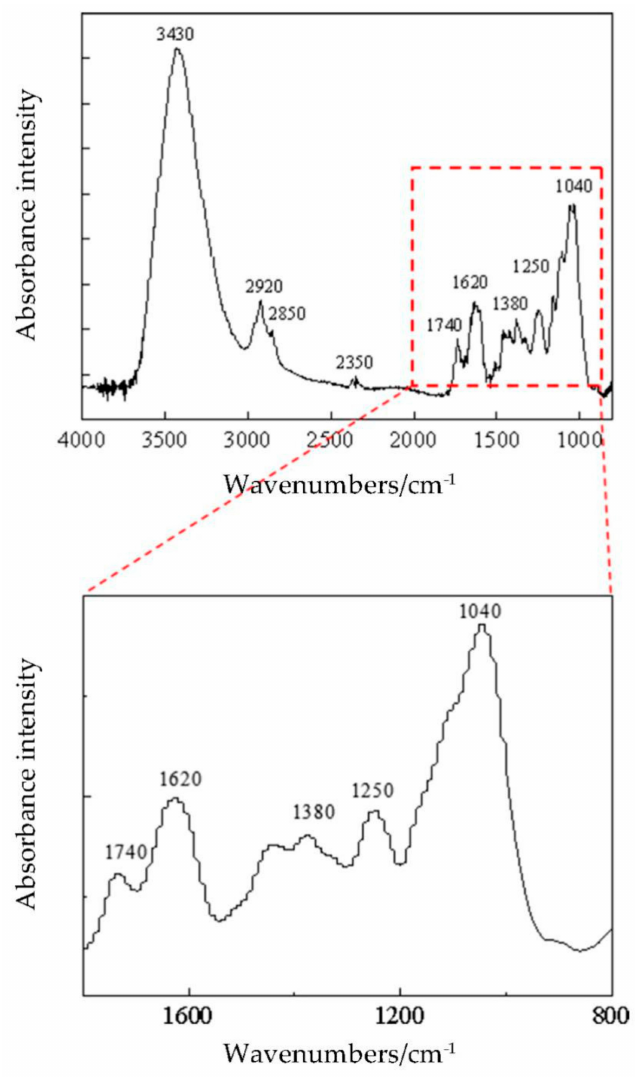
Figure 10. Fourier-transform infrared spectrogram and partial rendering of a poplar catkin